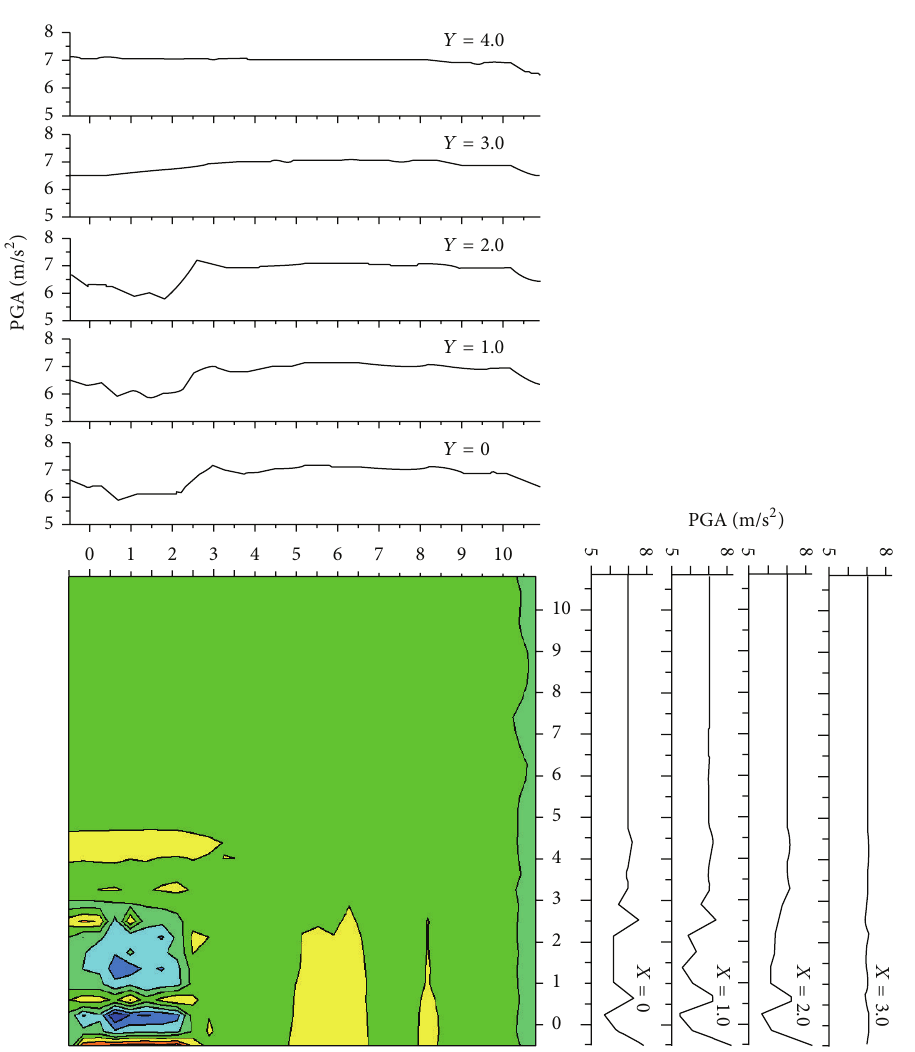
Figure 28: Peak ground acceleration distribution of URBAN6-6 with respect to nondimensional spatial coordinates (1/4 FE model, 𝐷 = 0.5 , El Centro, 𝑆𝑋 . Structure’s location is (0,0) , (0, 1) , (0, 2) , (1,0) , (1,1) , (1, 2) , (2,0) , (2,1) , and (2, 2) . The urban nondimensional width is 6.0; the nondimensional effective width of a structural group parallel to the excitation is 12.0, and the nondimensional effective width of a structural group perpendicular to the excitation is 9.0).